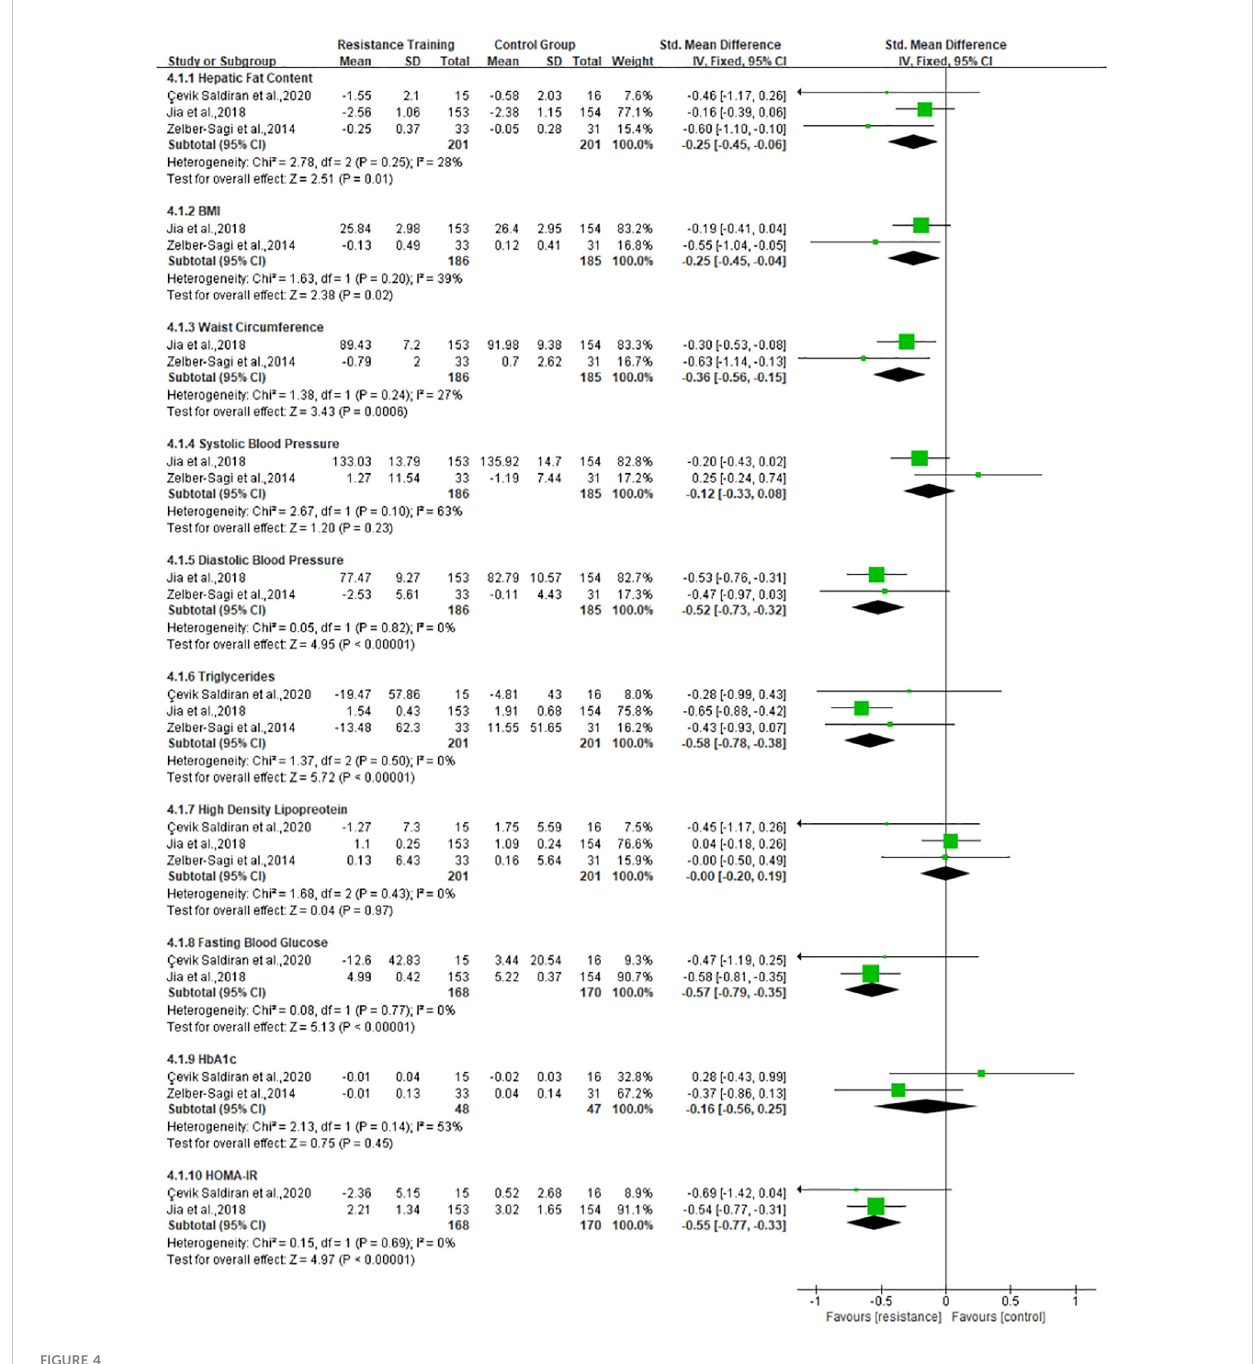
FIGURE 4 Effect of resistance training vs . control group on